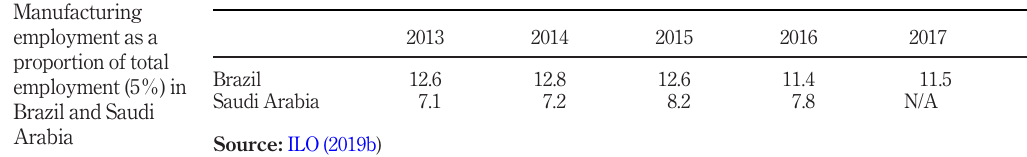
Table I. Manufacturing value added (MVA) and relevant indicators in Brazil and Saudi Arabia, various years, in millions USD (2010 constant) Source: UNIDO